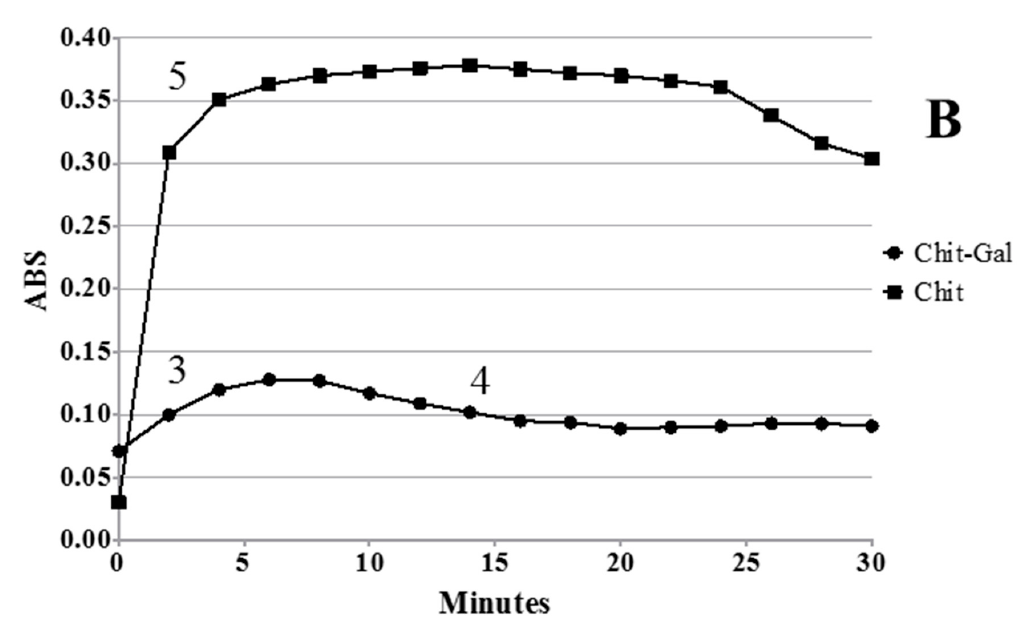
Figure 3. Formation profile of CaOx crystals. A . Formation profile in control condition and in the presence of chit-gal. B . Formation profile in the presence of chit-gal and Chit. 1, 3, and 5 indicate nucleation / growth phases. 2 and 4 indicate aggregation phase.